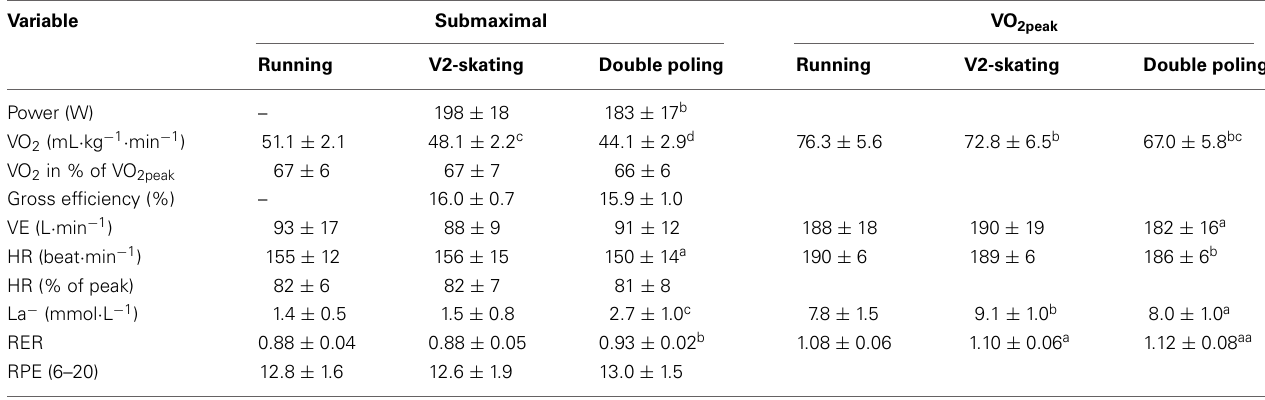
Table 1 | Work load and the physiological response during submaximal and VO 2peak test during running and the two skiing techniques (V2-skating and double poling; n =